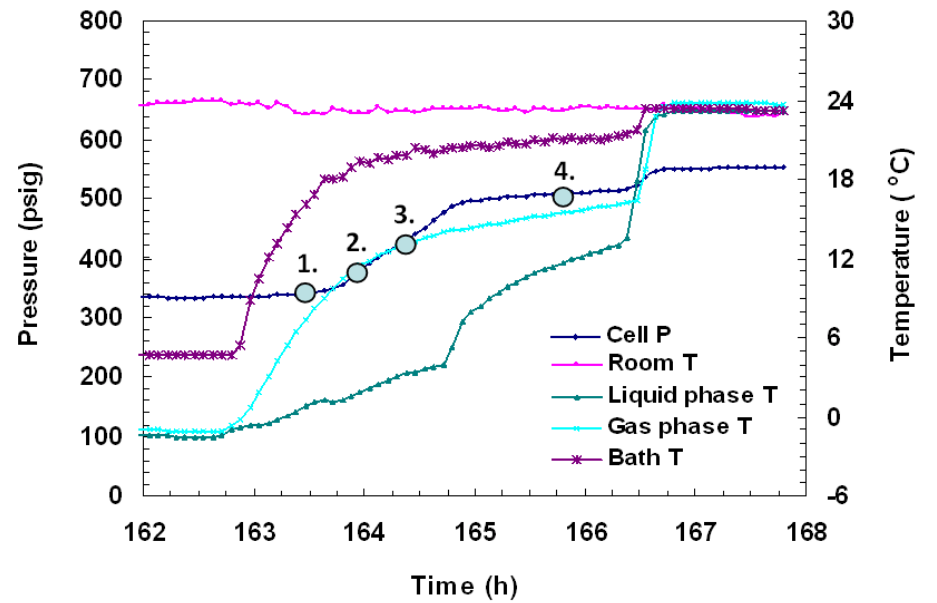
Figure 5. P/T versus time data plots during dissociation by thermal stimulation for Run 1. The run conditions are shown in Figure